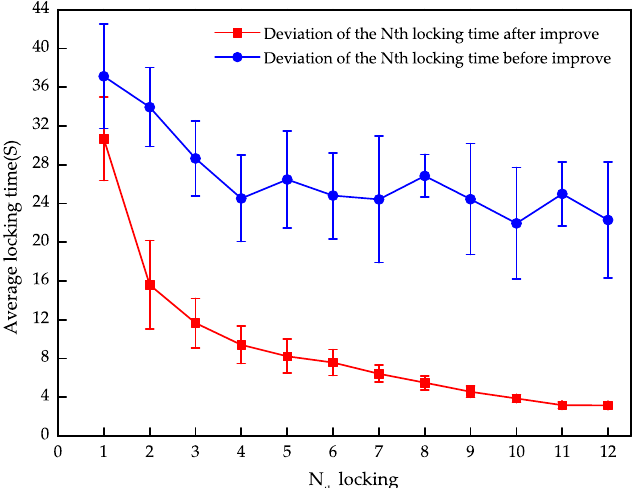
Figure 8. Comparison of locking time error bar before and after the system